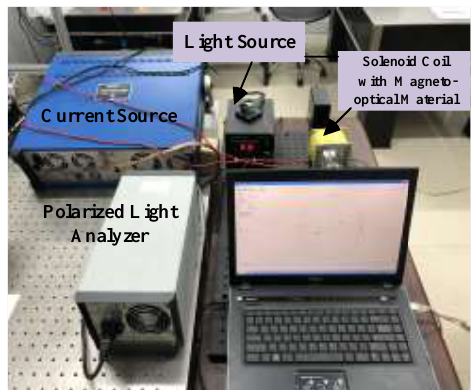
Figure 7. Schematic of experimental setup.